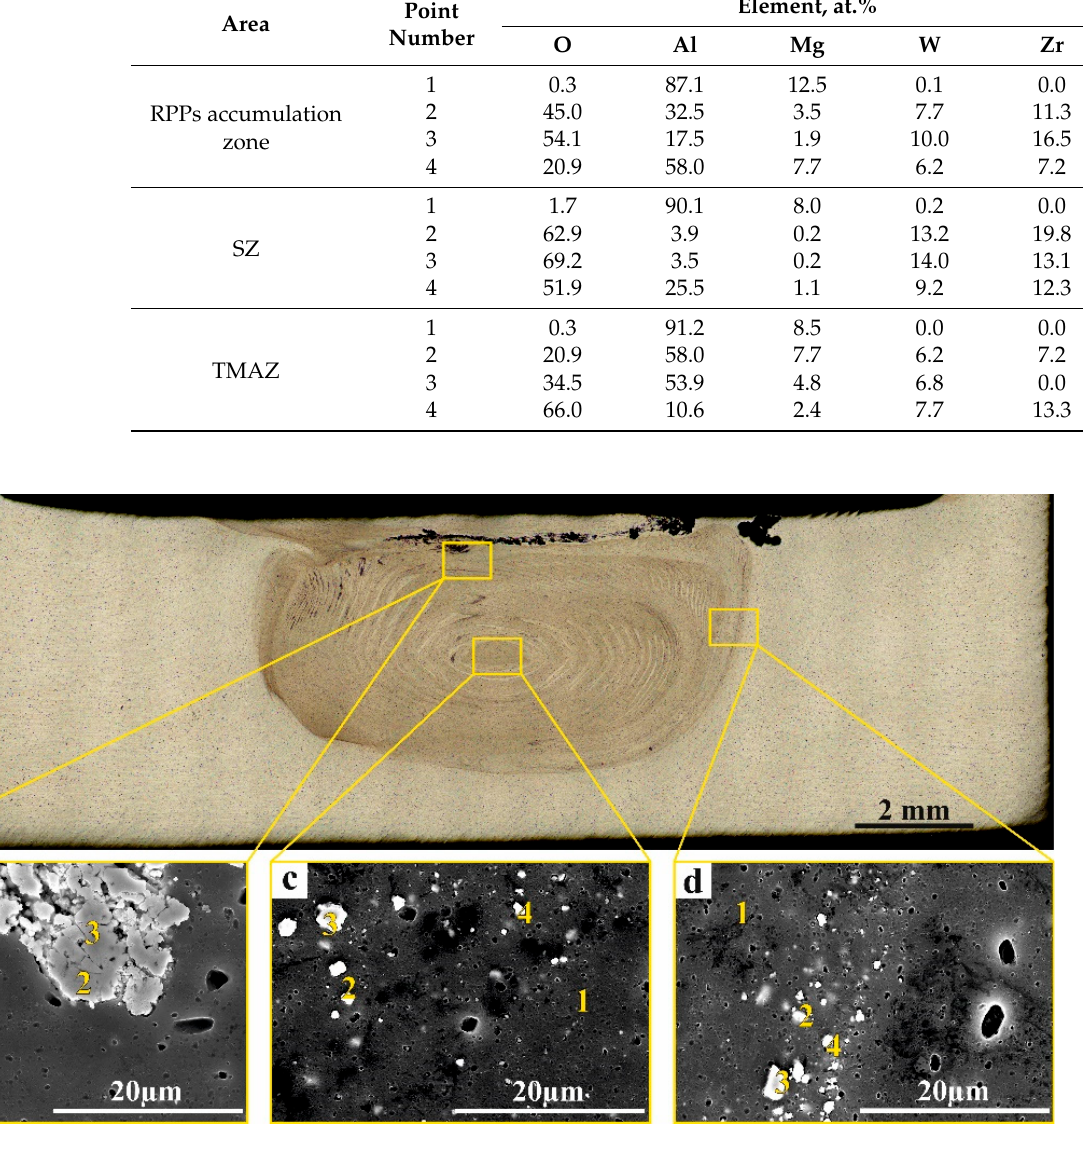
Figure 11. Macro ( a ) and micro ( b – d ) SEM graphs of FSP-ed RPPs/AA 5056 composite: ( a ) macro- graph section of FSP-ed RPPs/AA5056 composite after 4 consecutive passes; ( b ) RPP accumulation zone; ( c ) stir nugget zone; ( d ) thermomechanically affected zone. Numbers on ( b – d ) indicate probe zones for which EDS elemental concentrations were determined indicated in Table 1. Table 1. Chemical composition (EDS) of an etched section of FSP-ed RPPs/AA 5056 after 4 tool passes.